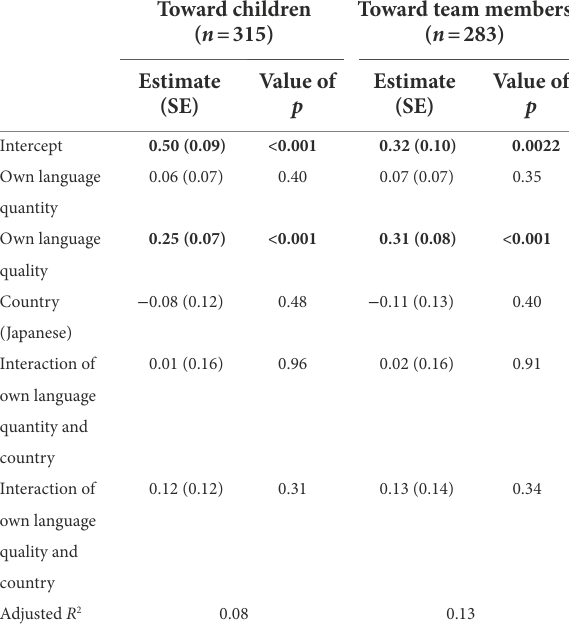
TABLE 7 The linear regression models predicting children’s non- verbal communicative behavior toward